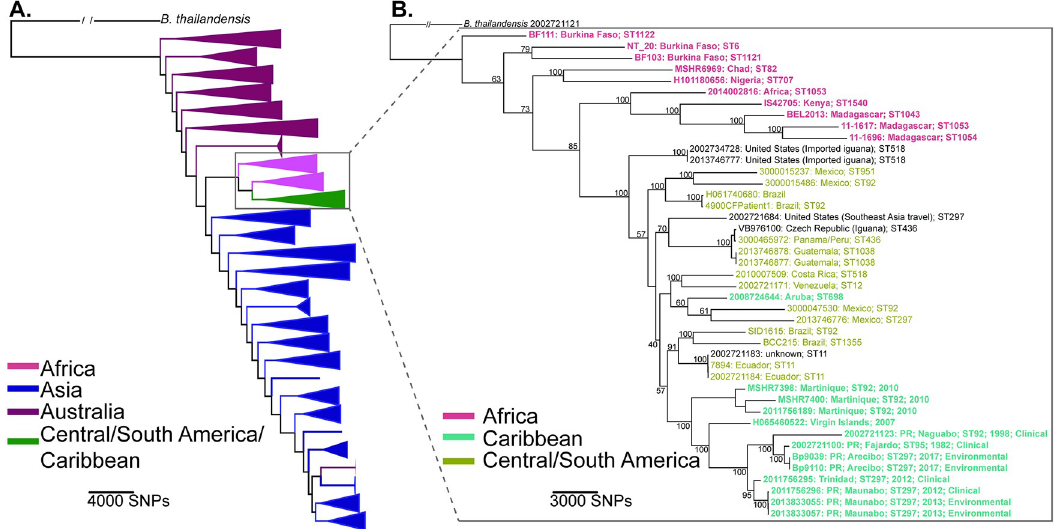
Fig 2. Burkholderia pseudomallei global whole genome phylogeny. Maximum-likelihood phylogeny of 414 globally-diverse B . pseudomallei isolates rooted with a B . thailandensis isolate; bootstrap values are reported on nodes. Two of the 55 B . pseudomallei isolates obtained from site 23 in this study are included (Bp9039 and Bp9110). (A) All 414 B . pseudomallei genomes with nodes collapsed. (B) Expanded nodes within the monophyletic group containing all included isolates ( n = 44) from Africa, Central and South America, Mexico, and the